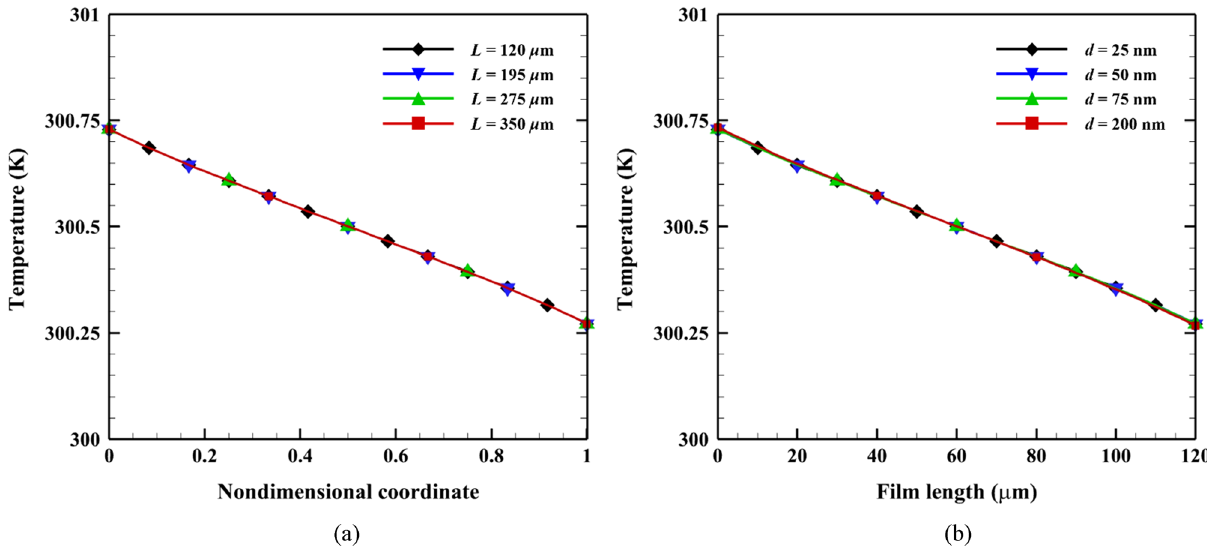
Figure 4. Temperature distribution ( a ) for various film lengths when d = 25 nm; ( b ) for various film thicknesses when L = 120